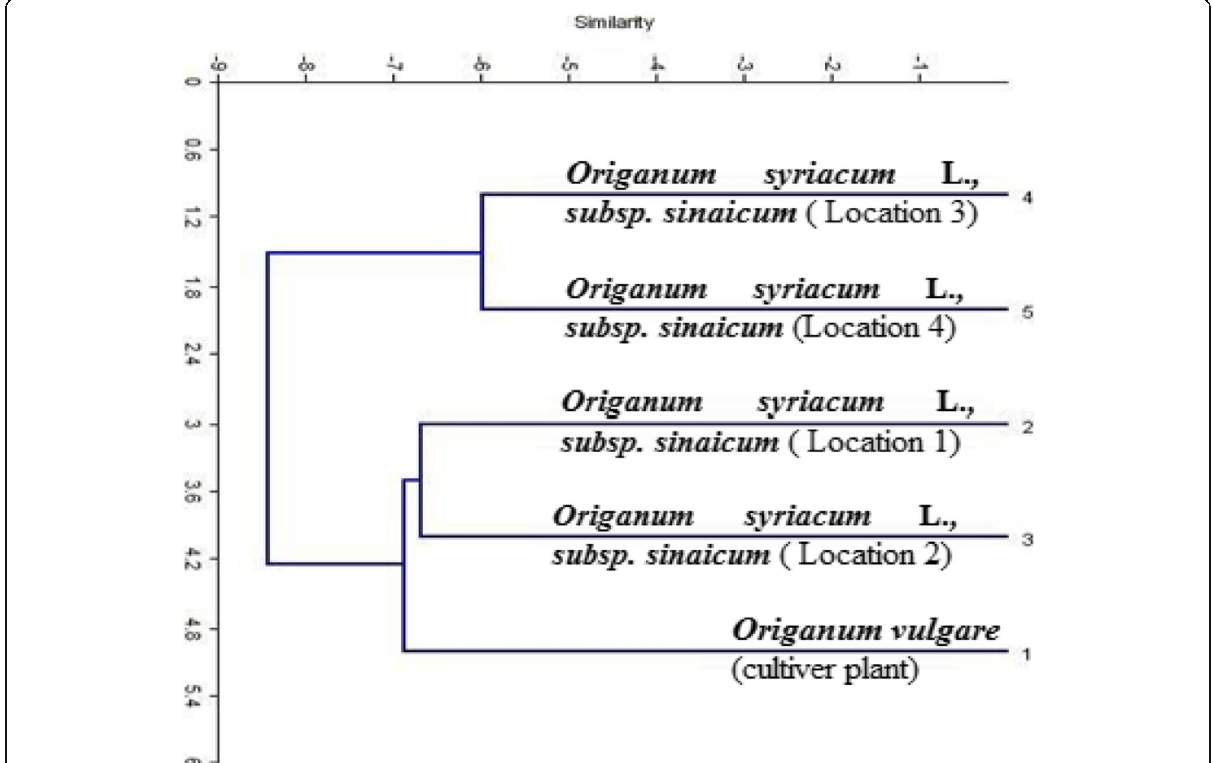
Fig. 3 The genetic relatedness within (1) Origanum vulgare (cultivar plant collected from Kirdasa region) and (2 – 5) Origanum syriacum L. subsp. sinaicum (Boiss.) (wild type collected from different locations around Saint Catherine Monastery) based on AFLP